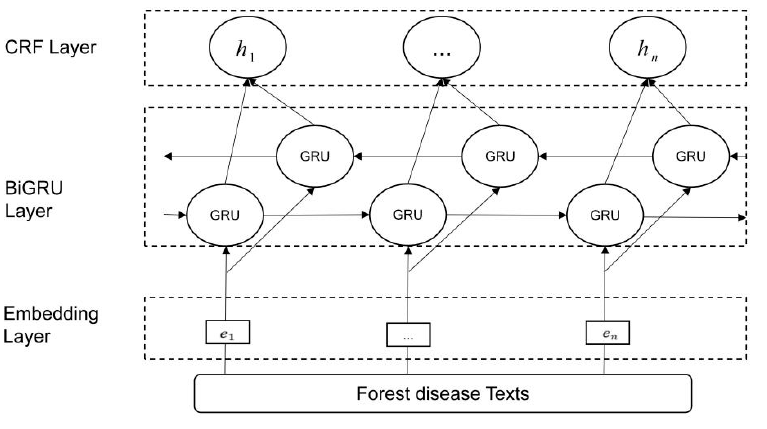
Figure 3. The structure of BiGRU-CRF method.